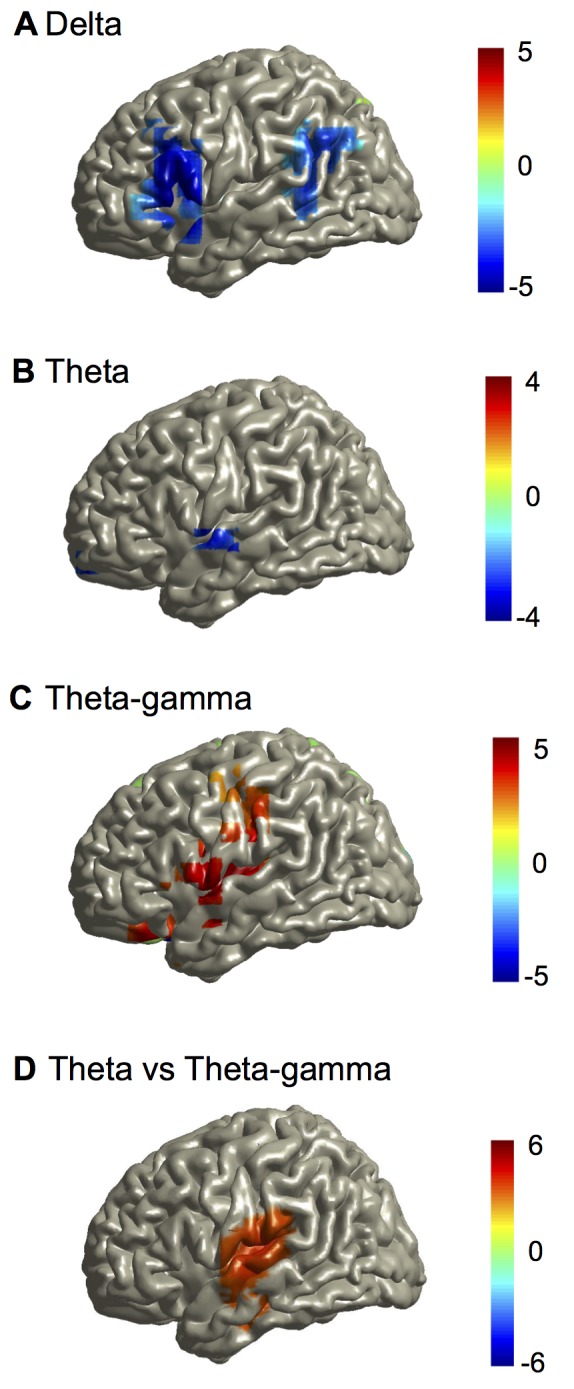
Mutual information group statistics of lateralisation in the story condition.All maps show t-statistics of lateralisation index (left−right)/(left+right) of mutual information. Red colours indicate lateralisation to the left cortical areas. Only the left hemisphere is shown because results are redundant in the right hemisphere. (A) Group statistical map of lateralisation of delta band MI (corresponding to Figure 2A). (B) Group statistical map of lateralisation of theta band MI (corresponding to Figure 2B). (C) Group statistical map of lateralisation of theta phase to gamma amplitude coupling (corresponding to Figure 2C). (D) Group statistical map comparing theta phase to gamma-amplitude lateralisation versus theta phase lateralisation. Maps are thresholded at p = 0.05 (FDR corrected).